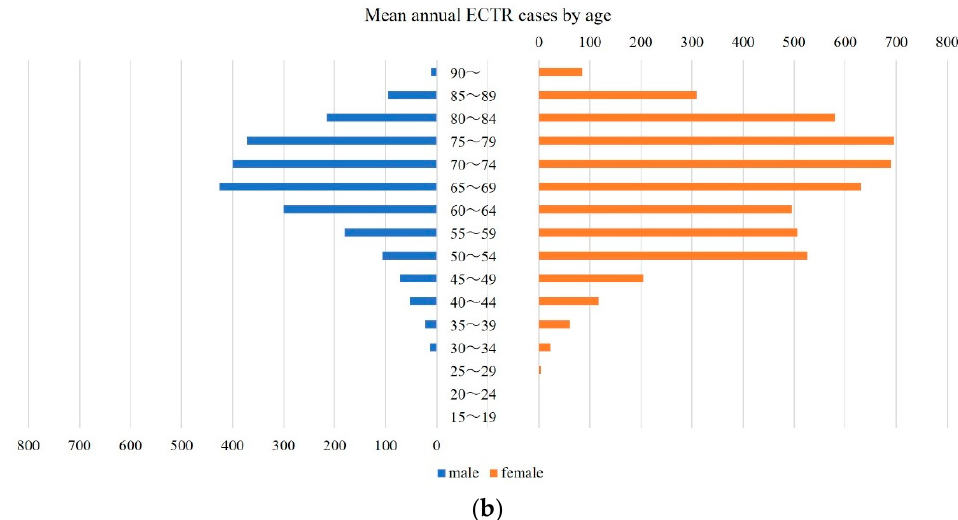
Figure 2. Mean age distribution by type of surgery and gender. Mean annual open carpal tunnel release (OCTR) ( a ) and endoscopic carpal tunnel release (ECTR) ( b ) cases by age. 3. Age- and sex-specific incidence of OCTR and ECTR.